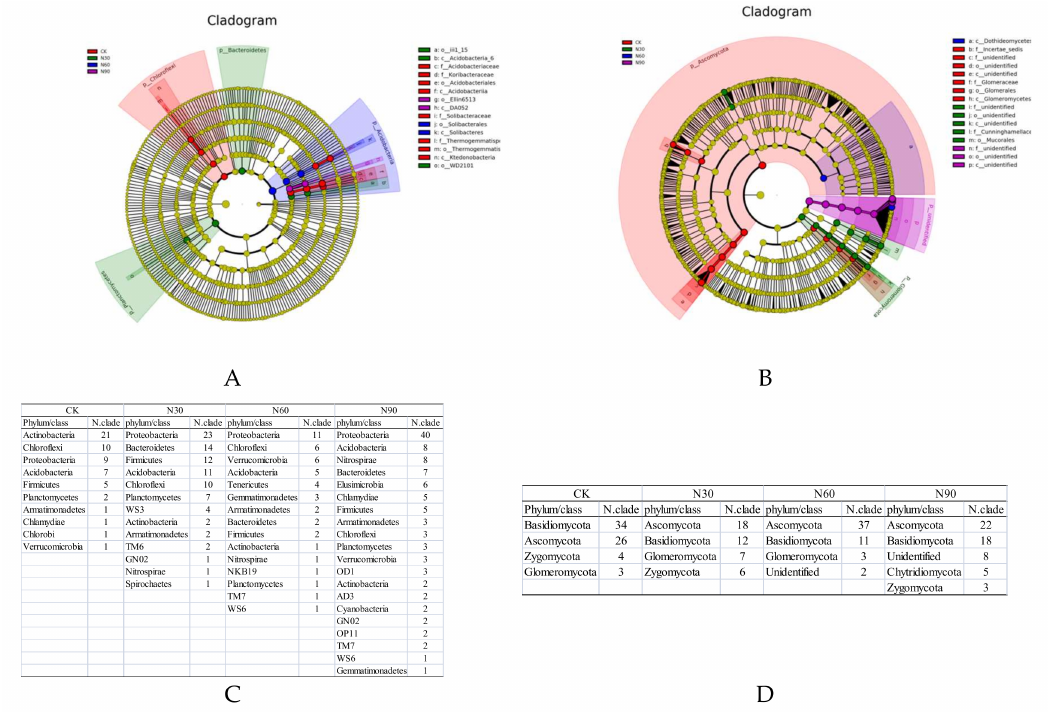
Figure 3. Discriminant taxa significantly retrieved by LEfSe analysis for bacterial and fungal communities at di ff erent SND levels. The cladogram shows the taxonomic representation of statistically consistent di ff erences among CK, N30, N60 and N90 treatment soil in ( A ) ‘bacteria’ and ( B ) ‘fungi’ at an LDA score ≥ 4 with the Kruskal–Wallis rank sum test. The circles radiating from inside to outside represent di ff erent taxonomic levels, i.e., kingdom, phylum, class, order, family, genus and species. Each small circle at a di ff erent taxonomic level represents a taxon. The diameter of the small circle is proportional to the relative abundance of the OTU. The coloring of the non-significant species is yellow, and the di ff erent taxa are colored with groups, representing the microbial groups that play an important role in the group. The names of the taxa are represented in the legend on the